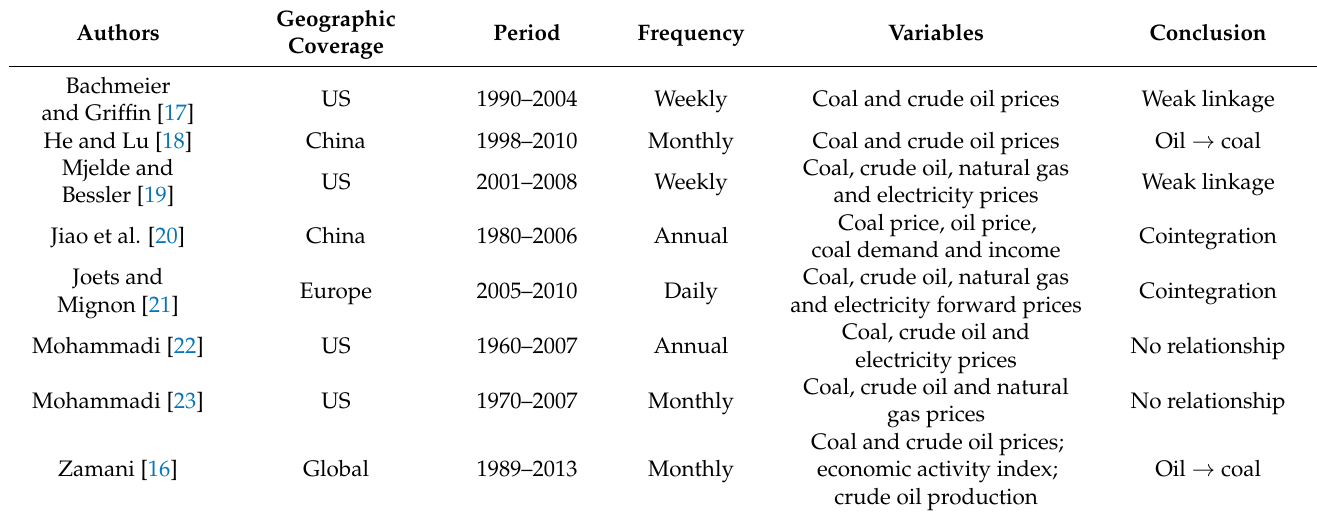
Table 1. Empirical studies on the relationship between coal and crude oil